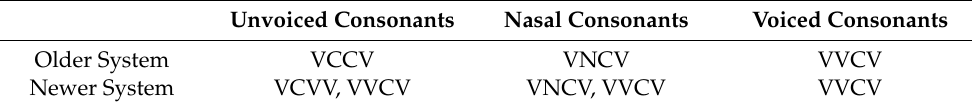
Table 2. The estimated change of phonological types of adjectives in Niigata dialects.